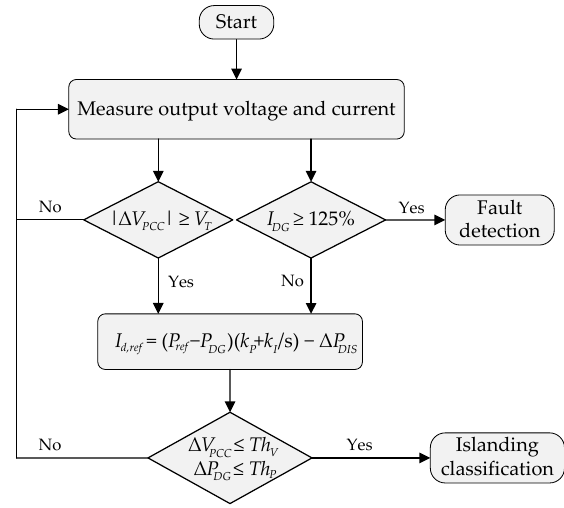
Figure 3. Flowchart of the proposed hybrid algorithm.